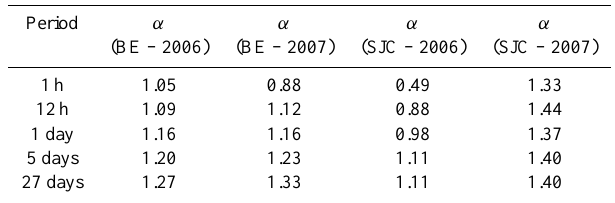
Table 1. µ parameter for each characteristic scale for both sites and years.